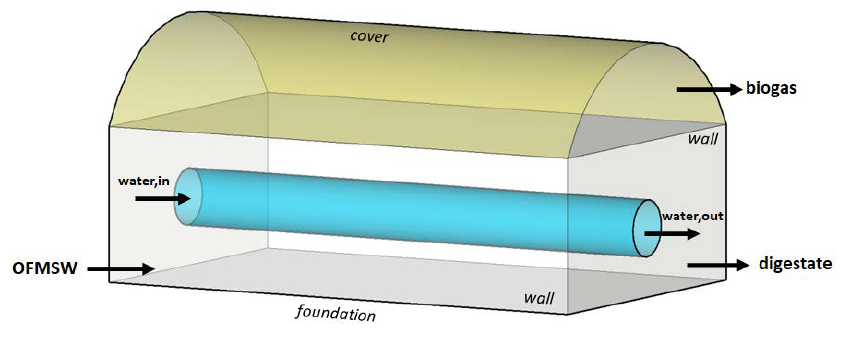
Figure 1. Sketch of the PFR.